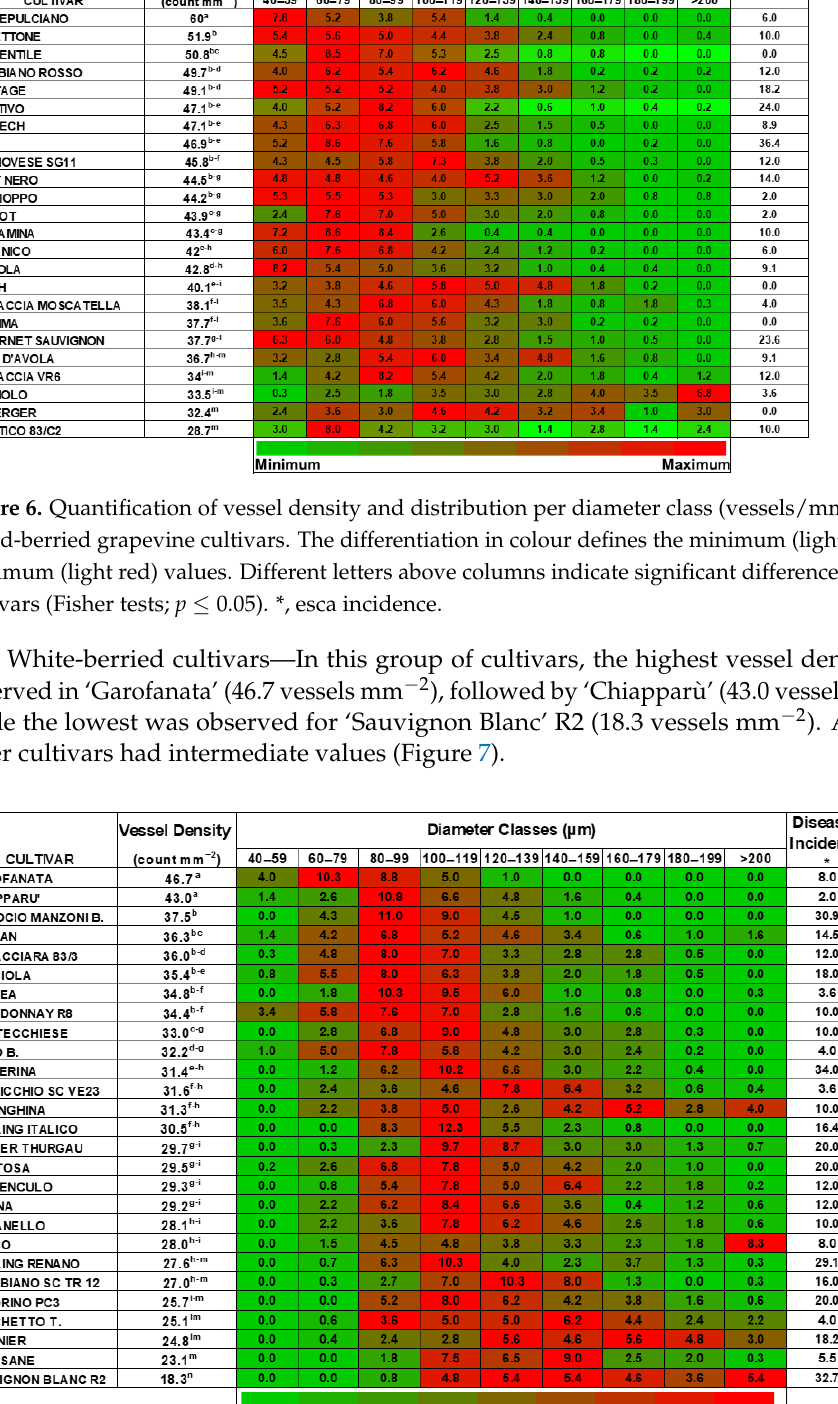
Figure 7. Quantification of vessel density and distribution per diameter class (vessels/mm 2 ) for the 27 white-berried grapevine cultivars. The differentiation in colour defines the minimum (light green) to maximum (light red) values. Different letters above columns indicate significant differences between cultivars (Fisher tests; p ≤ 0.05). *, esca incidence.